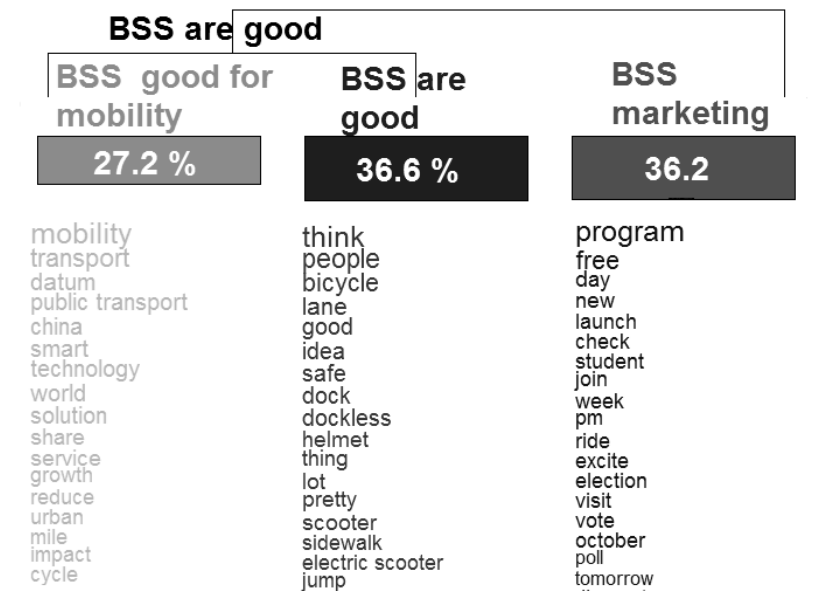
Figure 5. Quantitative topic clustering on strongly positive